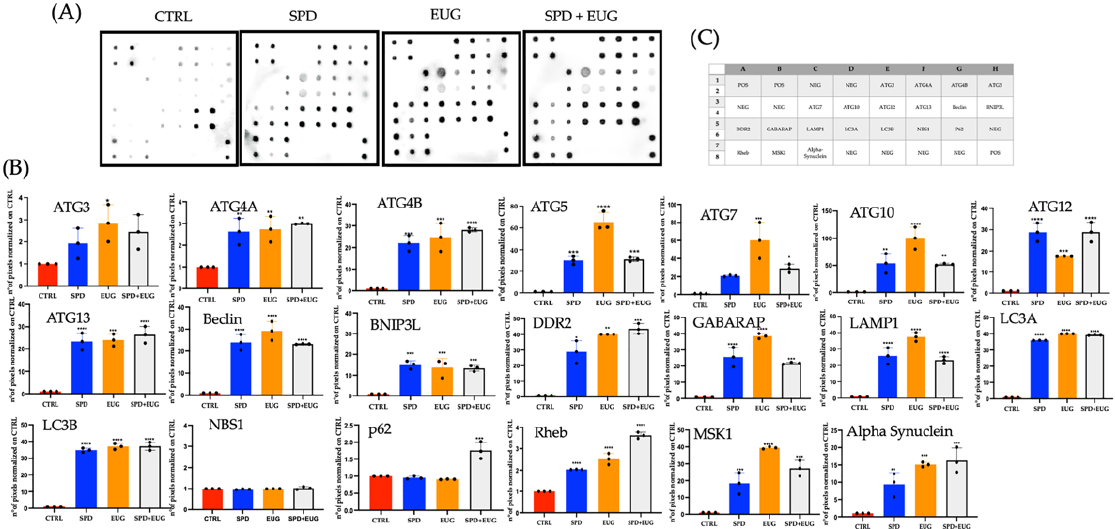
Figure 5. Expression ( A ) and expression quantification ( B ) of 20 individual human autophagy proteins, identified from the position location on the micro-array ( C ). Expression of the proteins ( A ) in the control (CTRL), 0.3 mM spermidine (SPD), 0.2 mM eugenol (EUG), 0.3 mM SP + 0.2 mM EUG (SPD + EUG) treated cells. Protein expression for each of the 20 proteins was quantified ( B ) for each treatment. The number of stars *, **, *** and **** represents significant differences between treatments as determined by one-way ANOVA at the 99% confidence level ( p < 0.01). The three black dots indicate the positioning of the individual replicates within the bar for each sample.